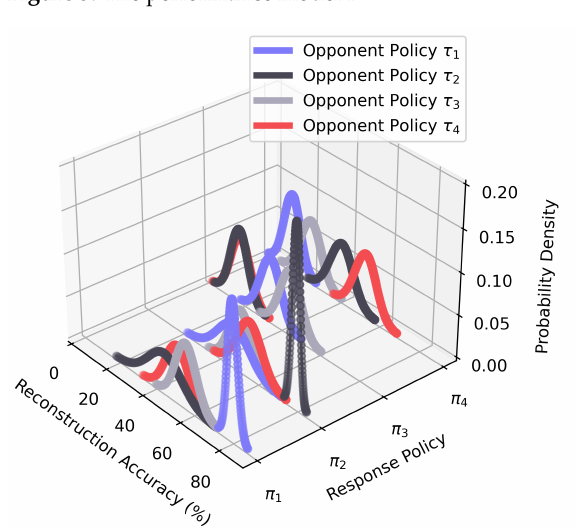
Figure 6. The reconstruction accuracy model Ω .